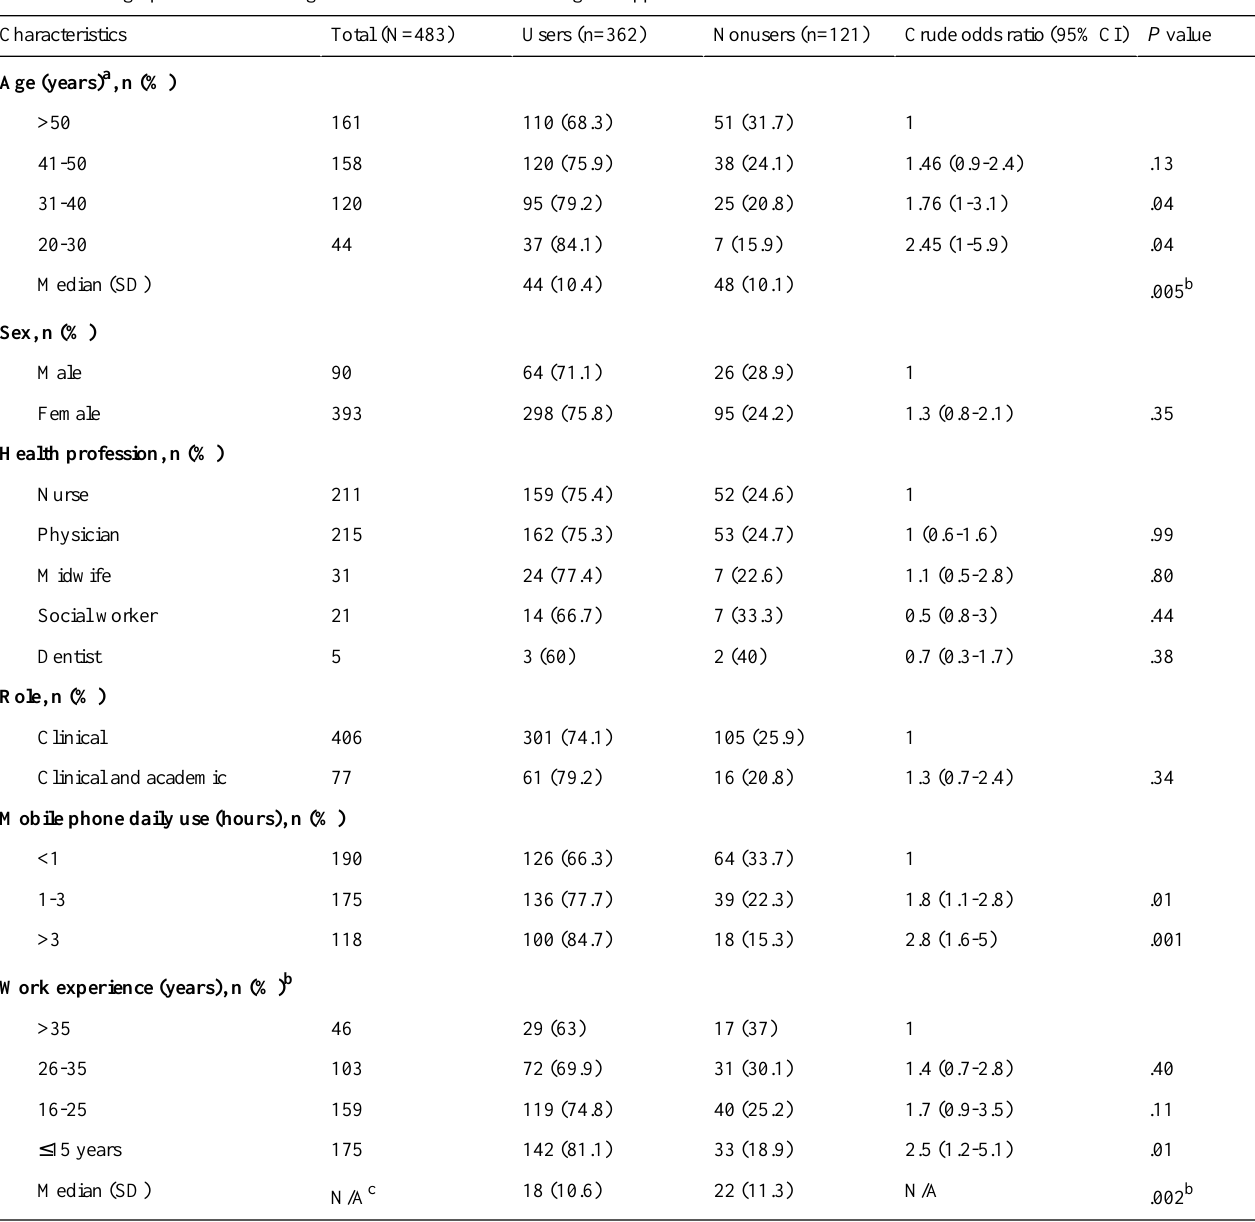
Table 1. Demographic data according to the use of social networking site